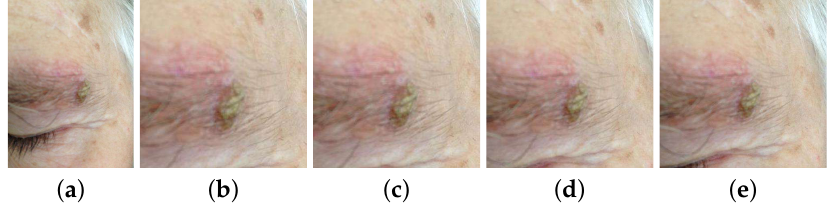
Figure 3. Examples of original and cropped images with different tolerances. ( a ) Original image. ( b ) Cropped with no tolerance. ( c ) Cropped with 10% tolerance. ( d ) Cropped with 30% tolerance. ( e ) Cropped with 50%